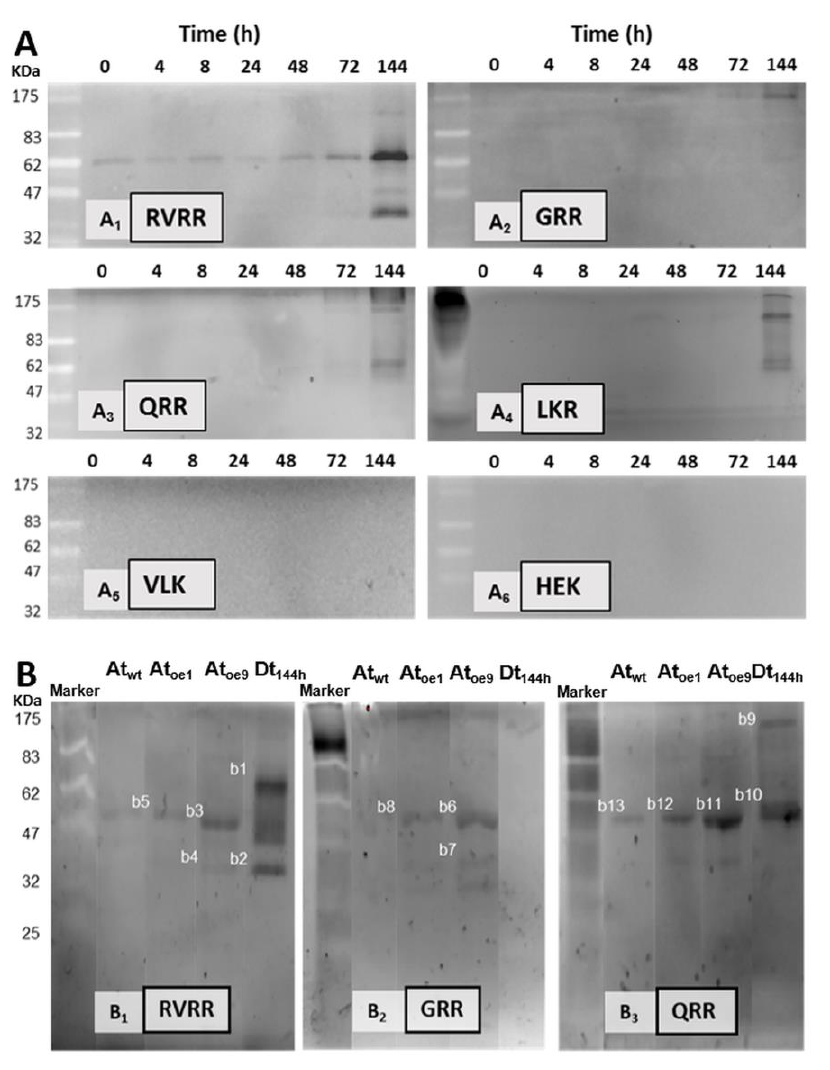
FIGURE 8. Zymograms of Rase and Kase activities in D. tertiolecta exposed to PAR + UVA + UVB (PAB) for six